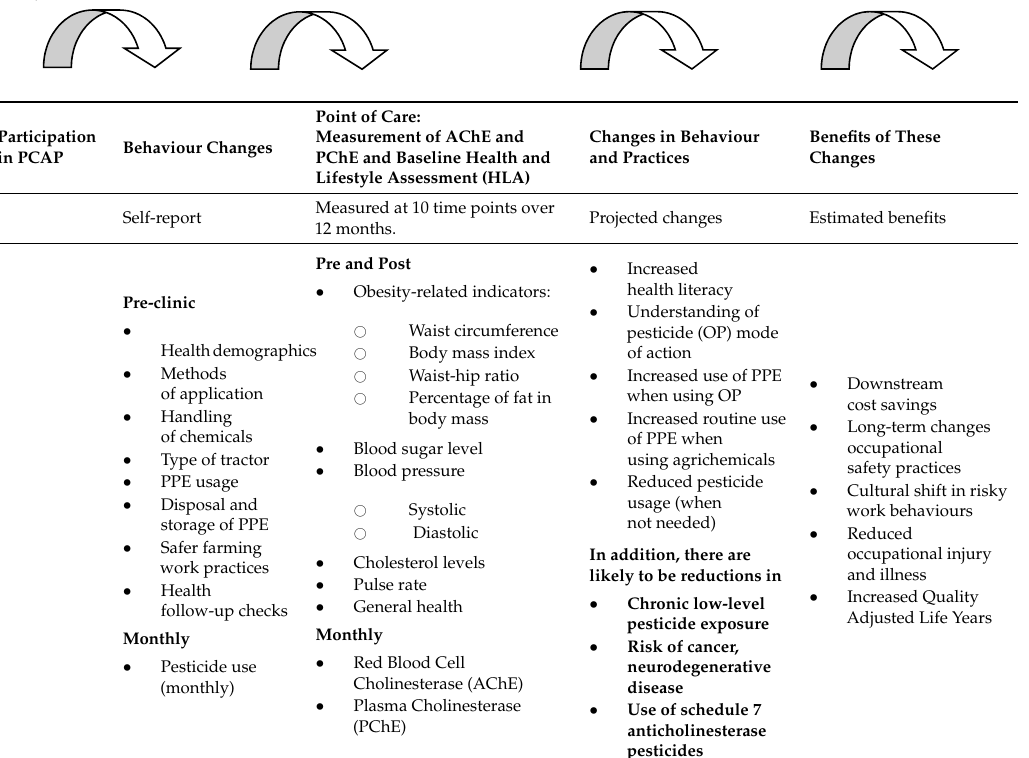
Table 1. Sequence of intended outcomes from the In-Field Personalised Cholinesterase Assessment Project (PCAP).